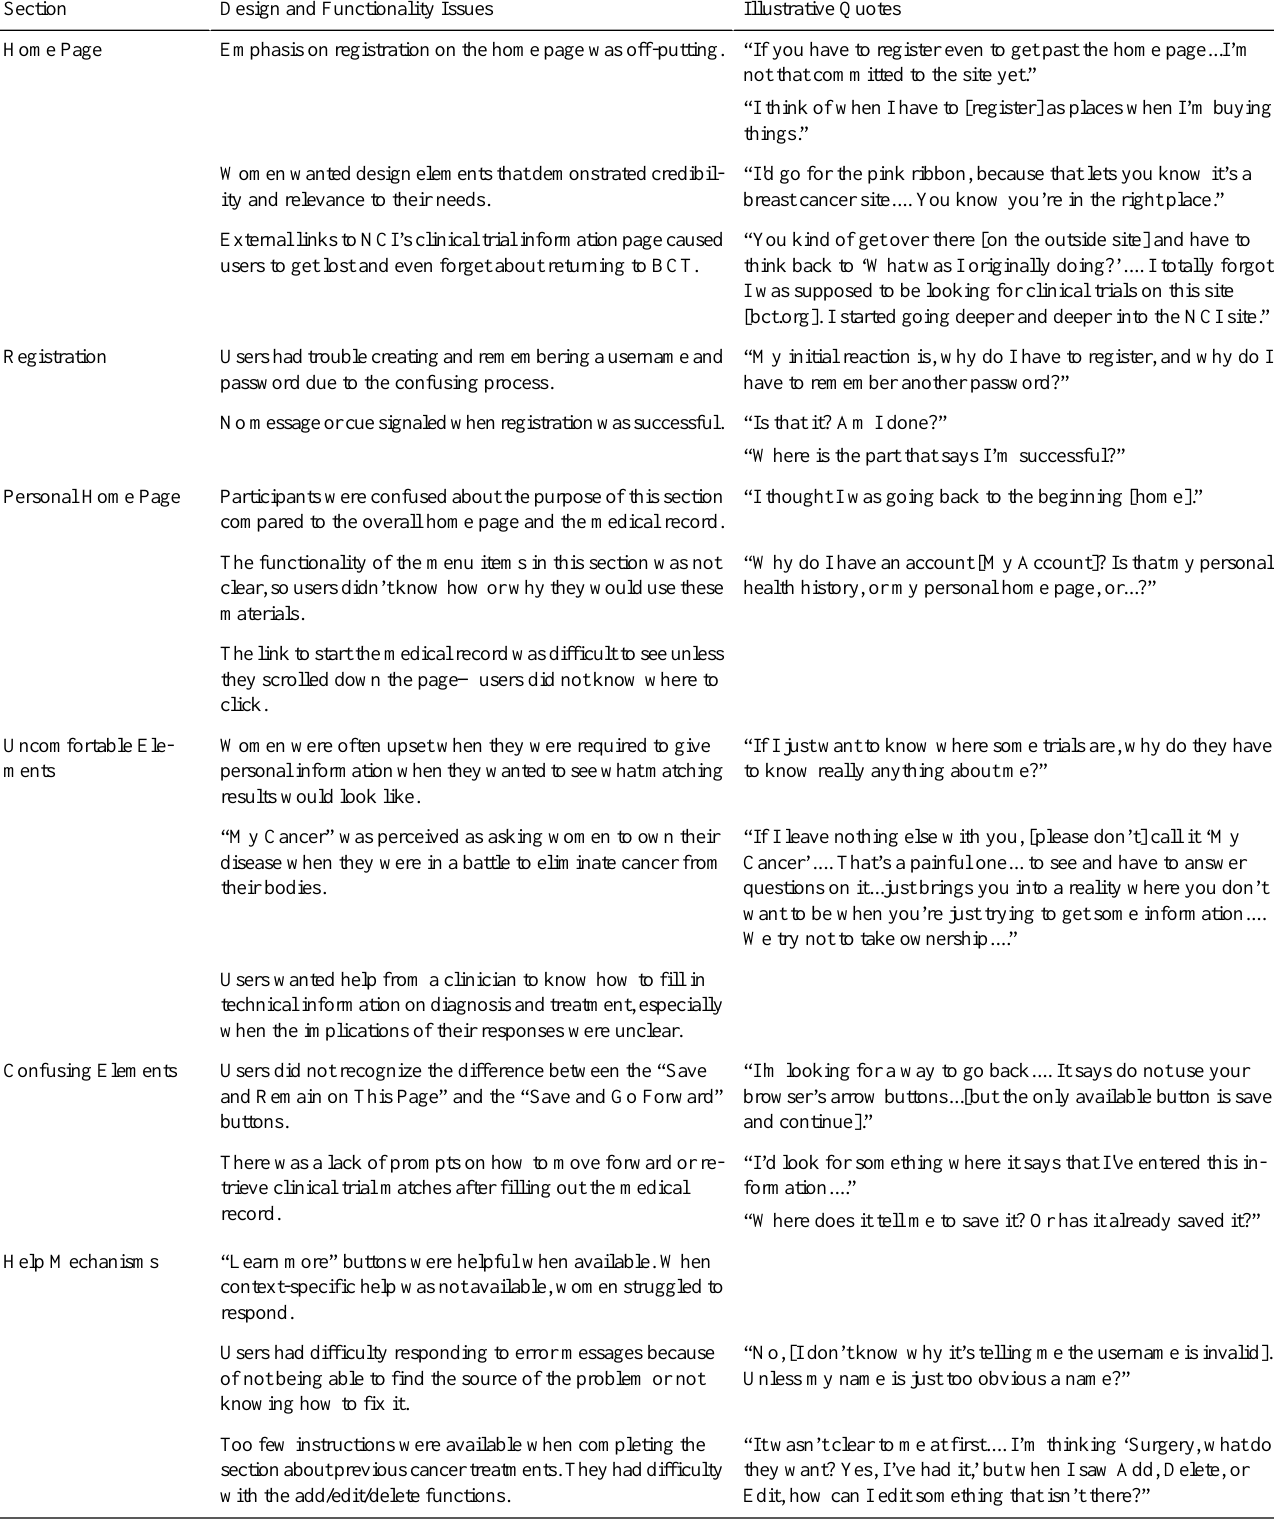
Illustrative QuotesDesign and Functionality